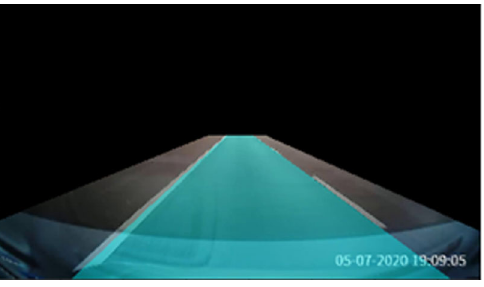
Figure 9. Lane region mapped back to original